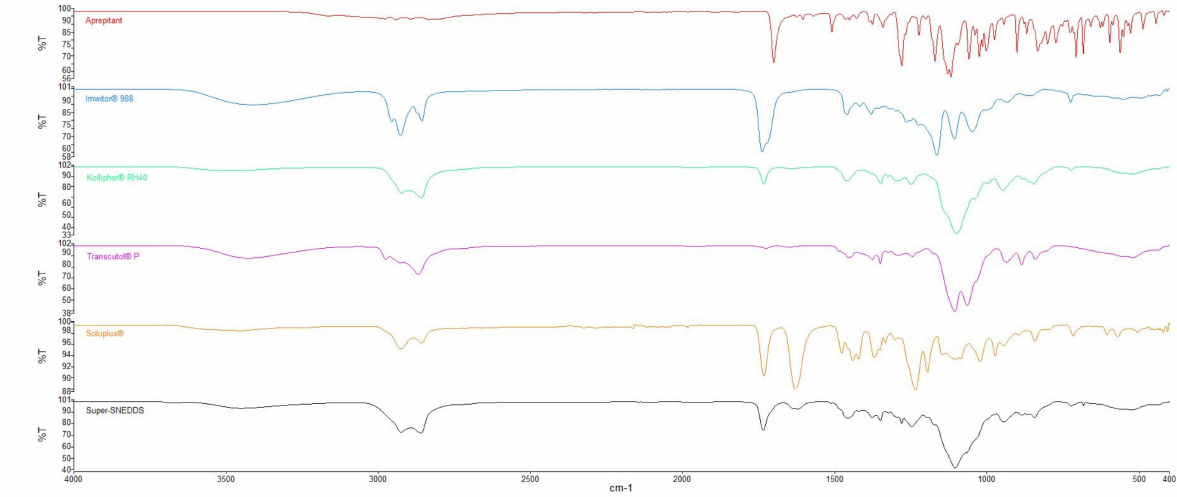
Figure 13. FTIR spectra of APR and excipients used in